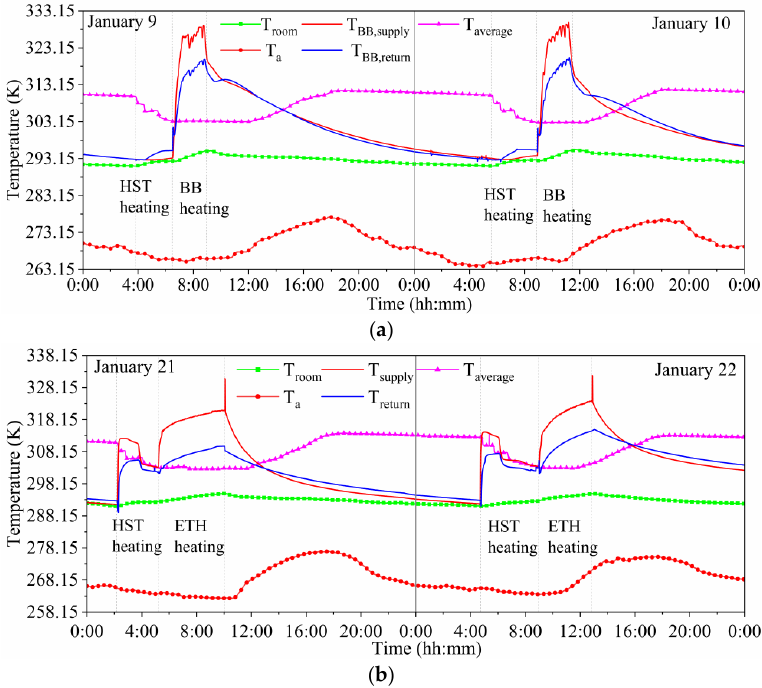
Figure 4. Experimental test data: ( a ) Mode 1 and ( b ) Mode 2.